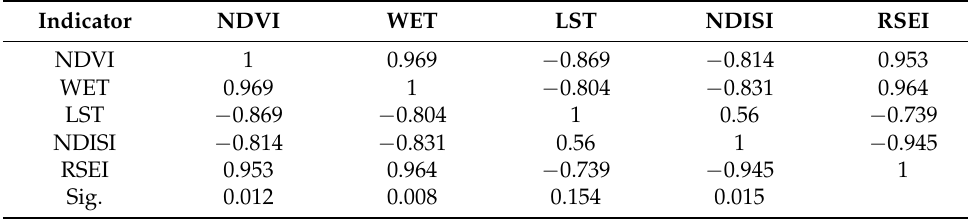
Table 3. Correlation matrix of indexes during